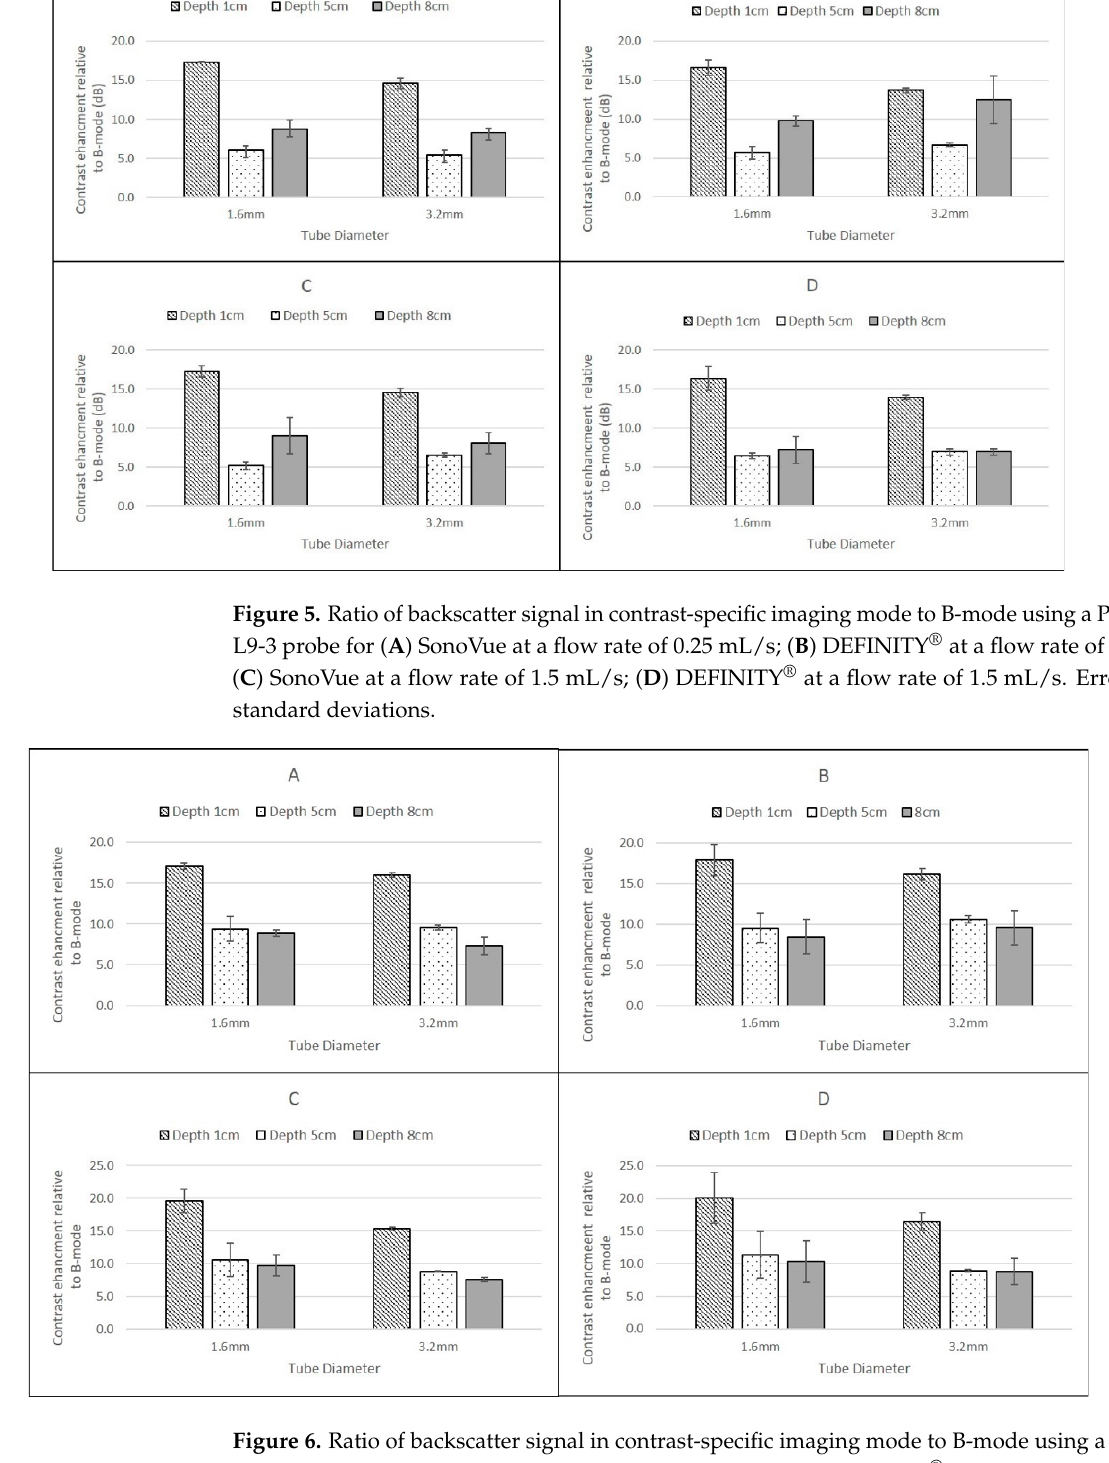
Figure 6. Ratio of backscatter signal in contrast-specific imaging mode to B-mode using a GE Logiq9 C2-9 probe for ( A ) SonoVue at a flow rate of 0.25 mL/s; ( B ) DEFINITY ® at a flow rate of 0.25 mL/s; ( C ) SonoVue at a flow rate of 1.5 mL/s; ( D ) DEFINITY ® at a flow rate of 1.5 mL/s. Error bars are standard deviations.